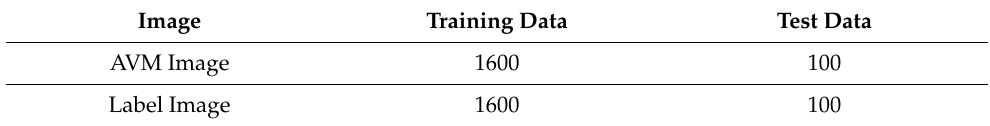
Table 1. AVM image-based parking area—travelable area dataset.